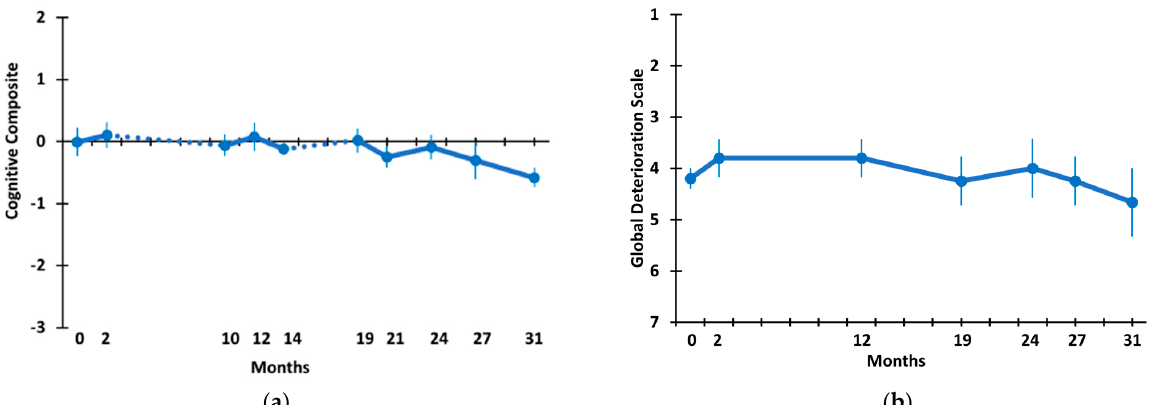
Figure 7. ( a ) Cognitive Composite of the eight measures in Figures 3–6 and ( b ) the Global Deterio- ration Score (GDS). Dotted lines in ( a ) indicate the 8M and 5M periods of no